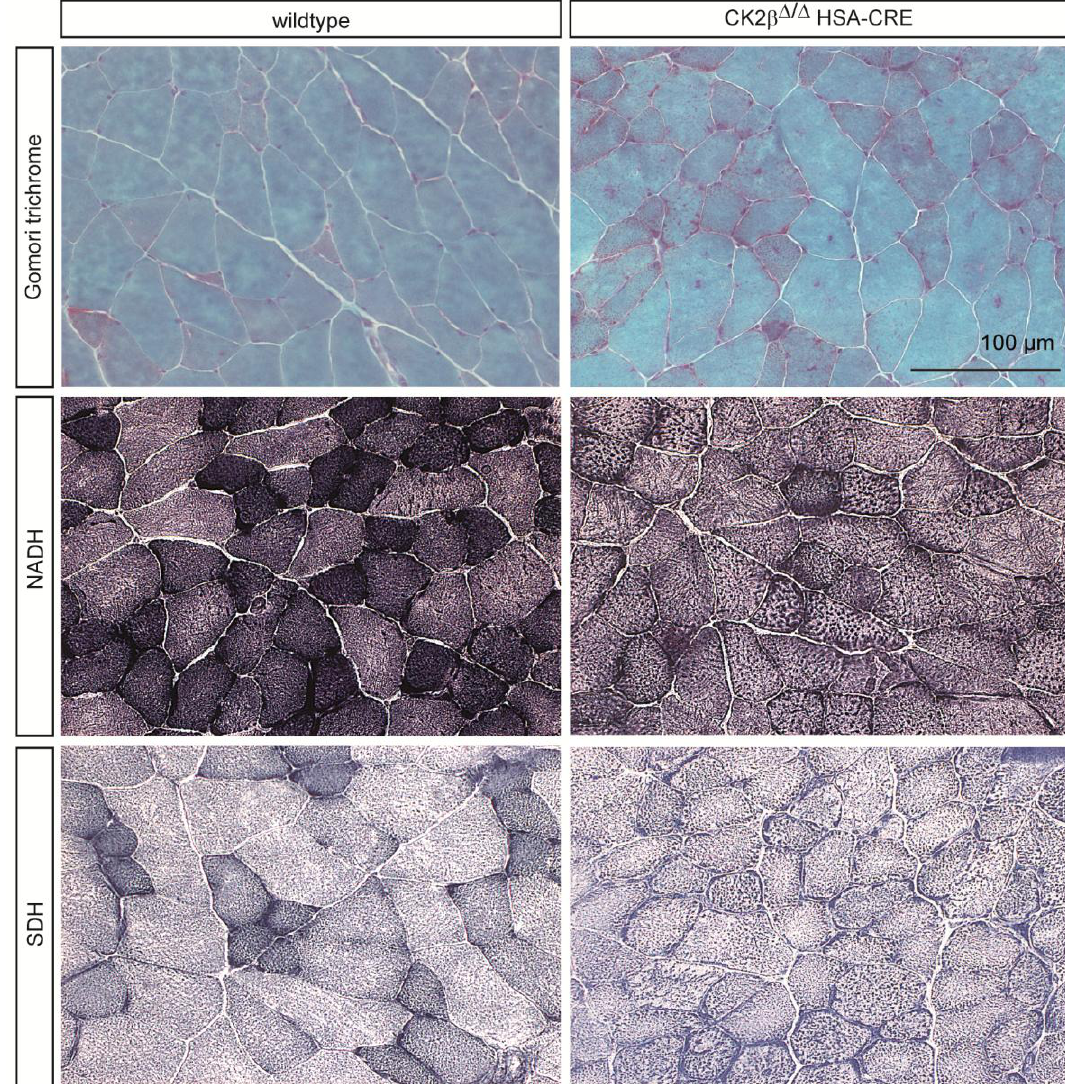
Figure 2. Typical images of hind limb cross sections after different histochemical stainings show plantaris muscles of wildtype and CK2 β -deficient mice at high resolution. Note that mitochondria appear accumulated at the subsarcolemmal membrane of CK2 β -deficient muscle fibers (red-colored in Gomori trichrome-stained muscle sections), while after NADH dehydrogenase and SDH stainings dark-colored slow type muscle fibers in wildtype cross sections are less dark-colored in CK2 β -deficient muscle fibers. Further, in comparison with wildtype muscles fiber diameters are significantly reduced on mutant muscle cross sections. The scale bar shown is representative for all images of muscle cross-sections in this figure.